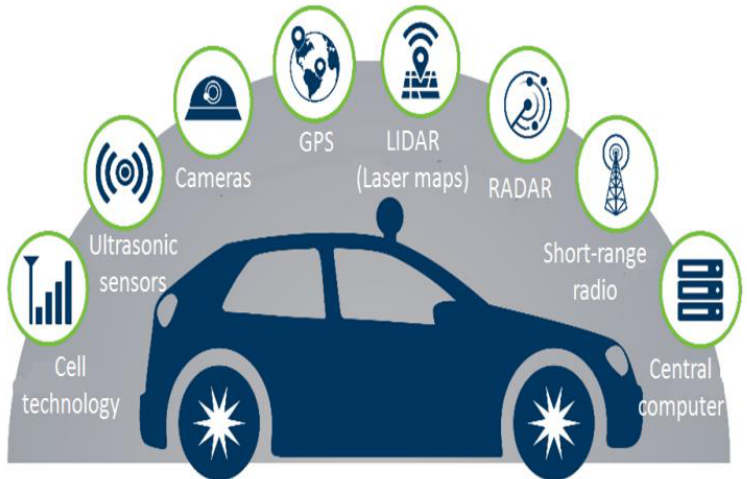
Figure 1. Illustration of the complexity of modern vehicles including numerous types of sensors: ultrasonic sensors, camera systems, GPS, LIDAR, radar, a central computer that process the data and communication systems that enable information exchange.